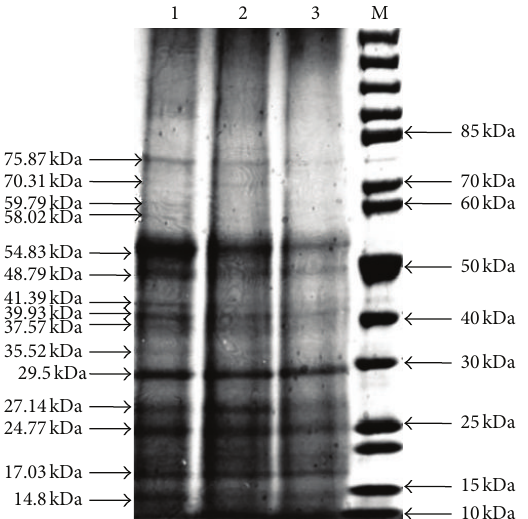
Figure 5: Total protein profiles of leave (1:phenotypically normal, 2: 50% mantled, 3: 100% mantled, and M:PageRuler Unstained Protein